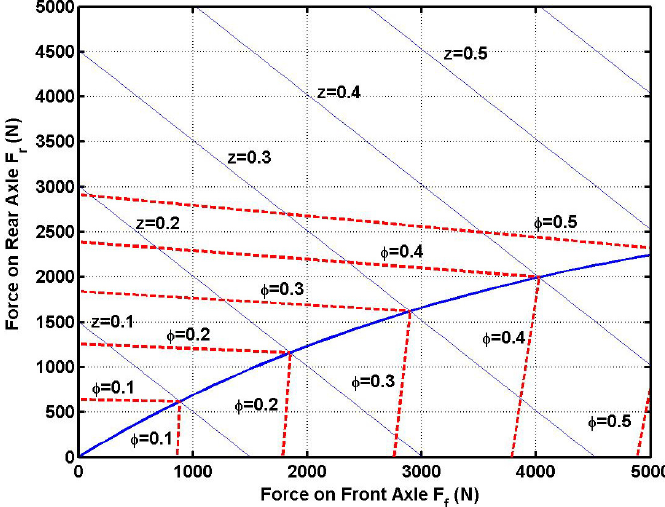
Figure 4. Braking force distribution between front and rear